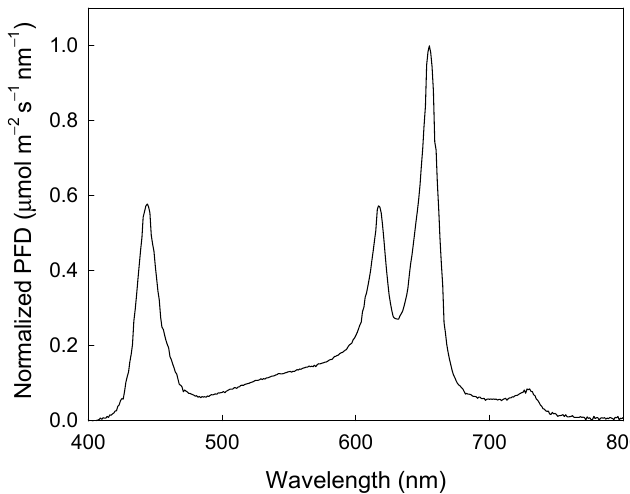
Figure 5. Normalized photon flux density (PFD) of the custom-made light-emitting diode (LED) arrays used for photochemical measurements.